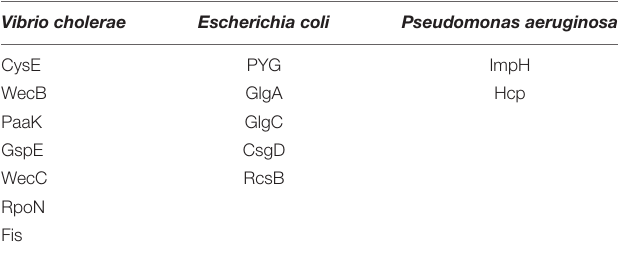
TABLE 3 | List of mapping proteins in biofilm formation of Vibrio cholerae , Escherichia coli , and Pseudomonas aeruginosa . Vibrio